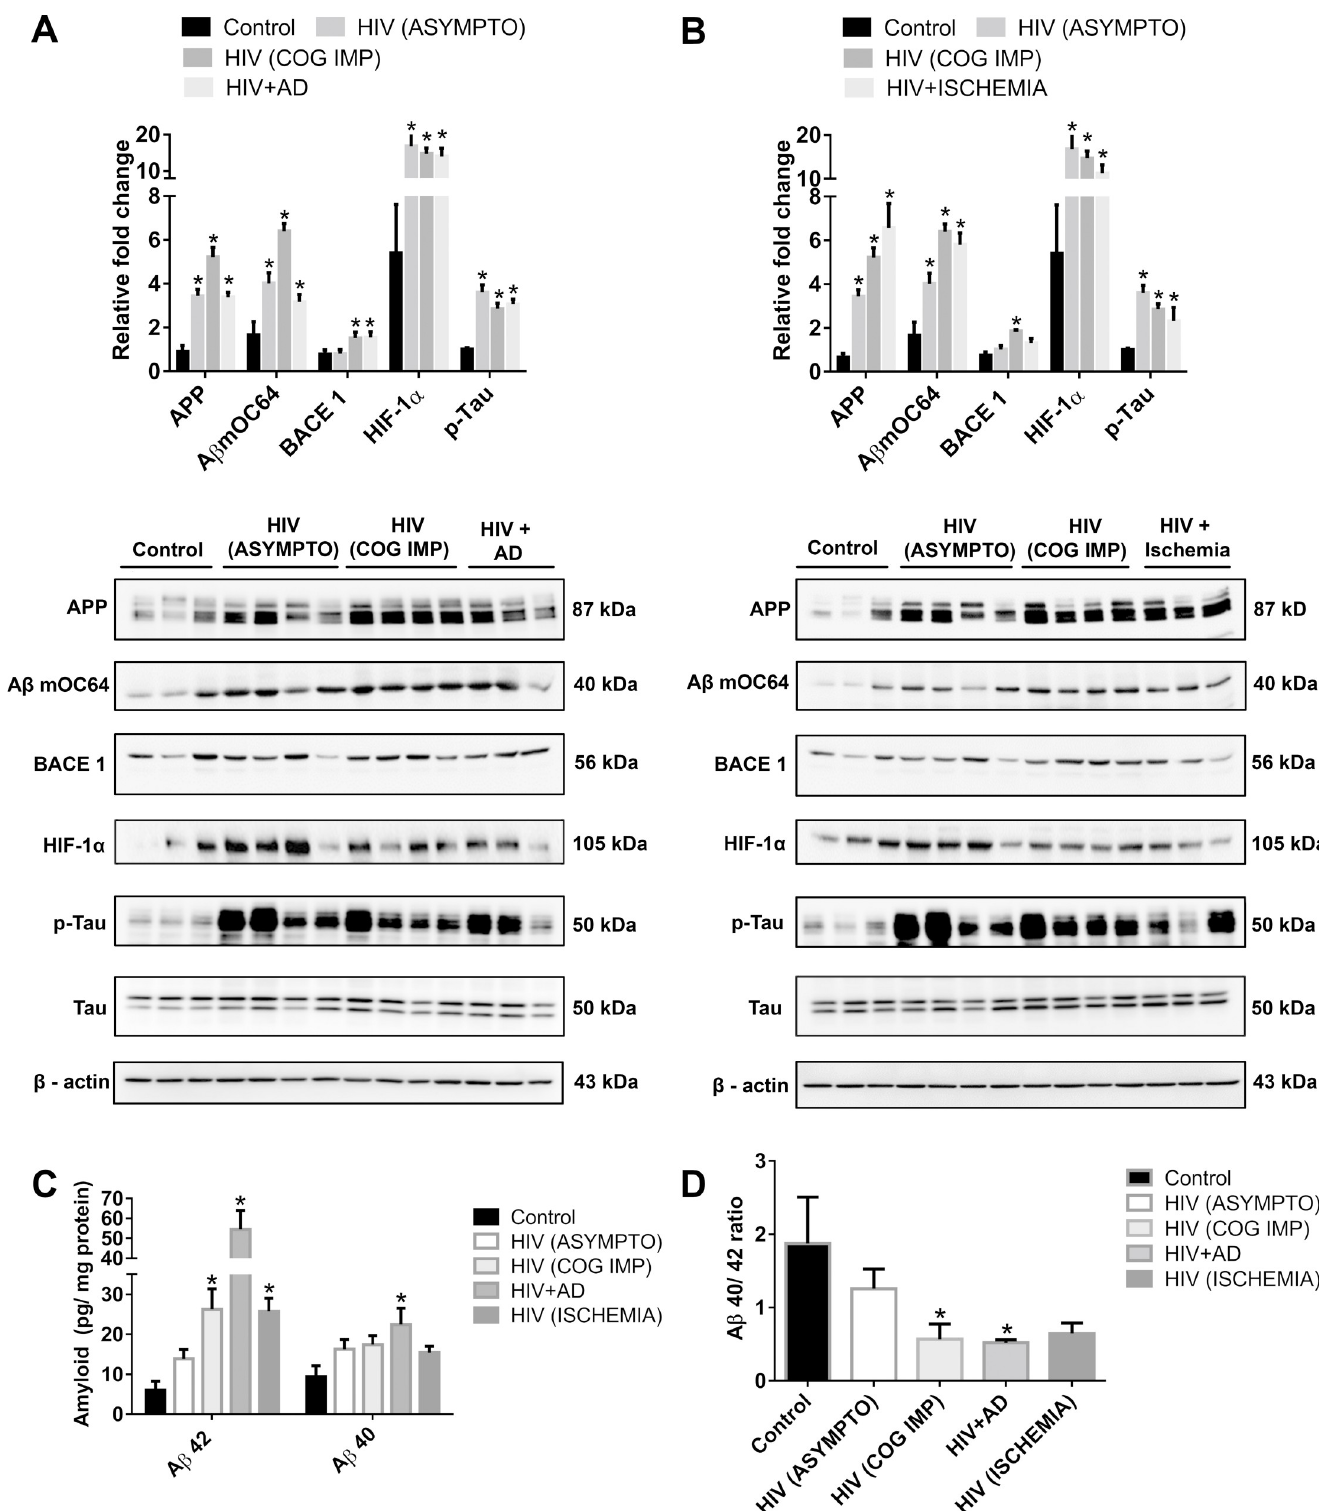
Fig 1. Amyloidopathy and neurofibrillary tangles in the FCs of individuals infected with HIV. (A) Representative western blots showing the expression of APP, A β mOC64, BACE1, HIF-1 α , p-Tau, and Tau in the FC of control (uninfected, n = 3), patients infected with HIV with asymptomatic [HIV (ASYMPTO), n = 4], cognitive impairment [HIV (COG IMP), n = 4], those with neurofibrillar pathology (HIV + AD, n = 3), (B) as well as with cerebral ischemia (HIV + Ischemia, n = 3). β -actin